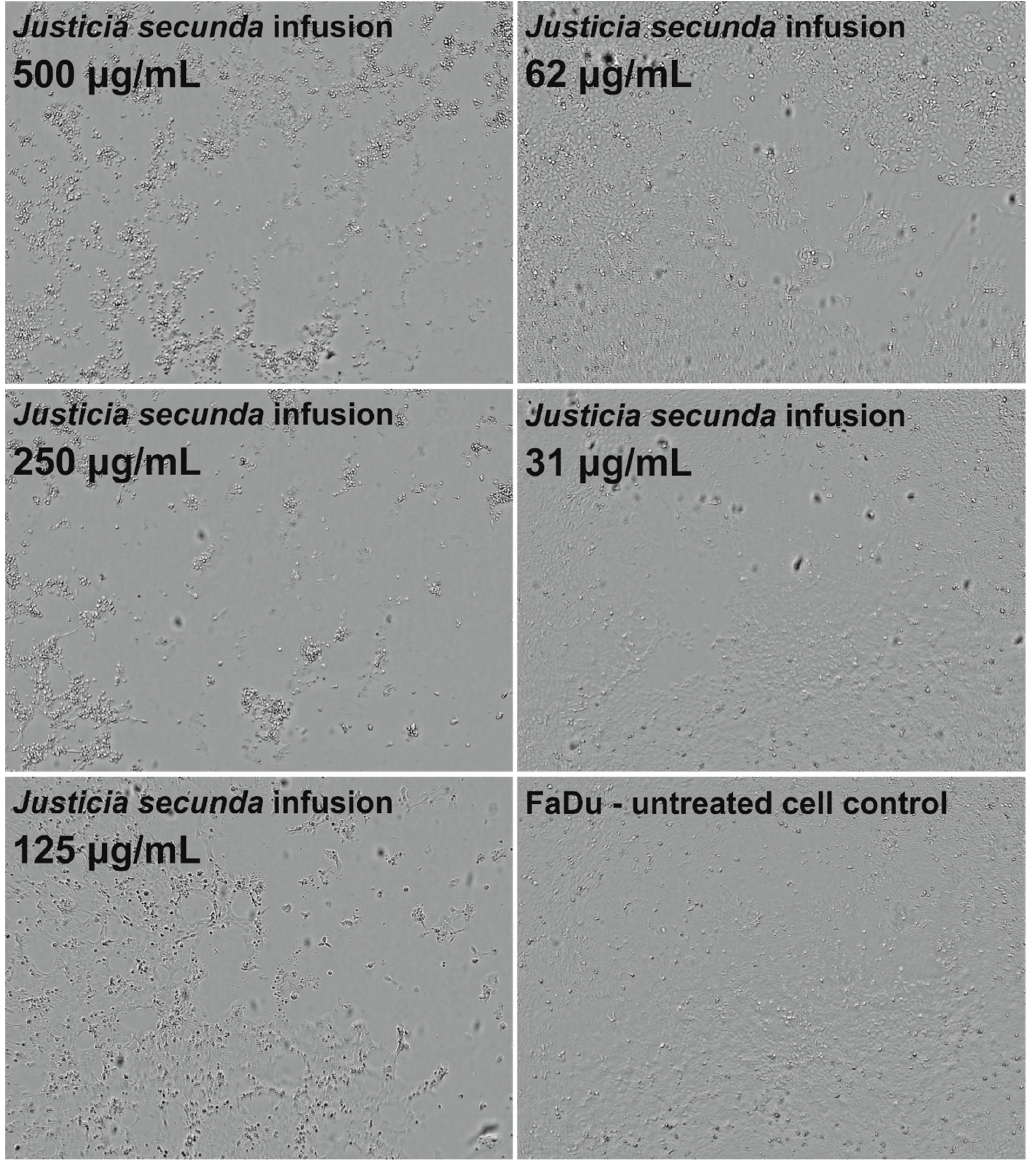
Figure 3. Influence of Justicia secunda infusion on the morphology of FaDu cells’ monolayer after 72 h incubation .